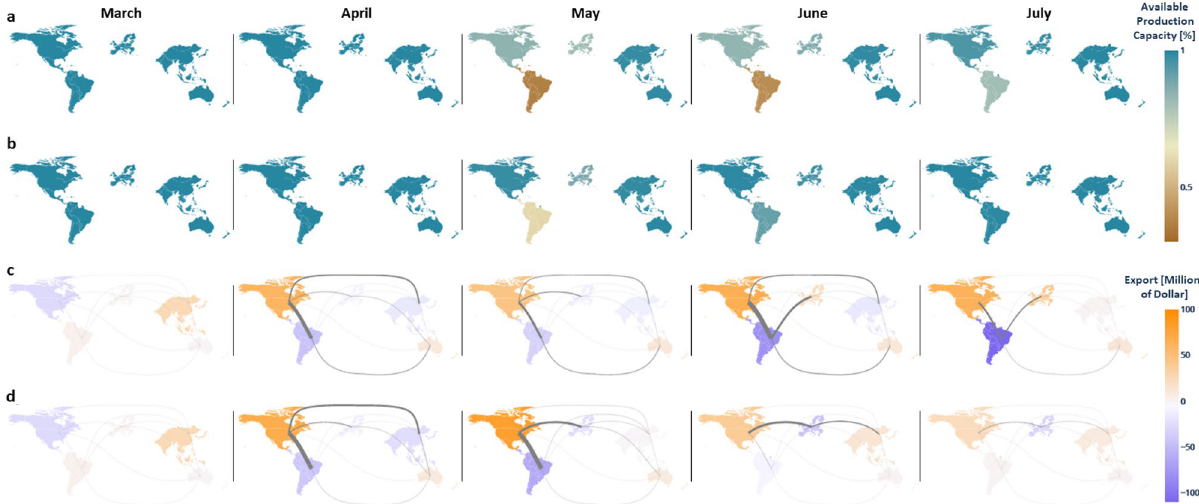
Figure 6. Production disruption and trade decisions of different containment strategies. (a) The dynamics of available production capacity by region in the ODS strategy. The color bar represents the percentage of available production capacity of each region. (b) The dynamics of available production capacity in the OCN scenario. (c) The total import and export decisions of each month in the ODS strategy; The strength of connections of regions marked by the width of the corresponding lines. (d) The total import and export decisions of each month in the OCN strategy; the strength of connections of regions marked by the width of the corresponding